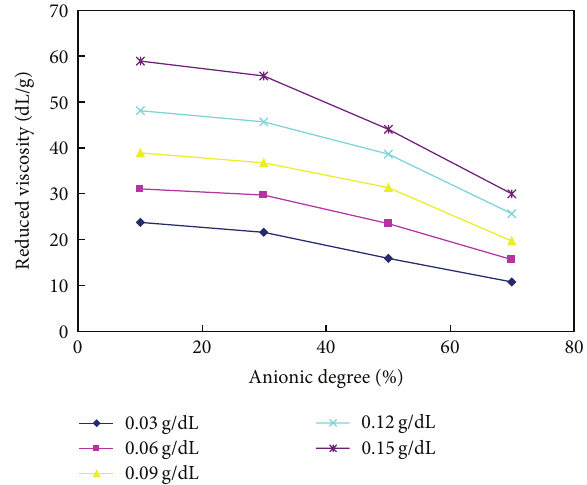
Figure 5: Variation of reduced viscosity versus anionic charge at various copolymer